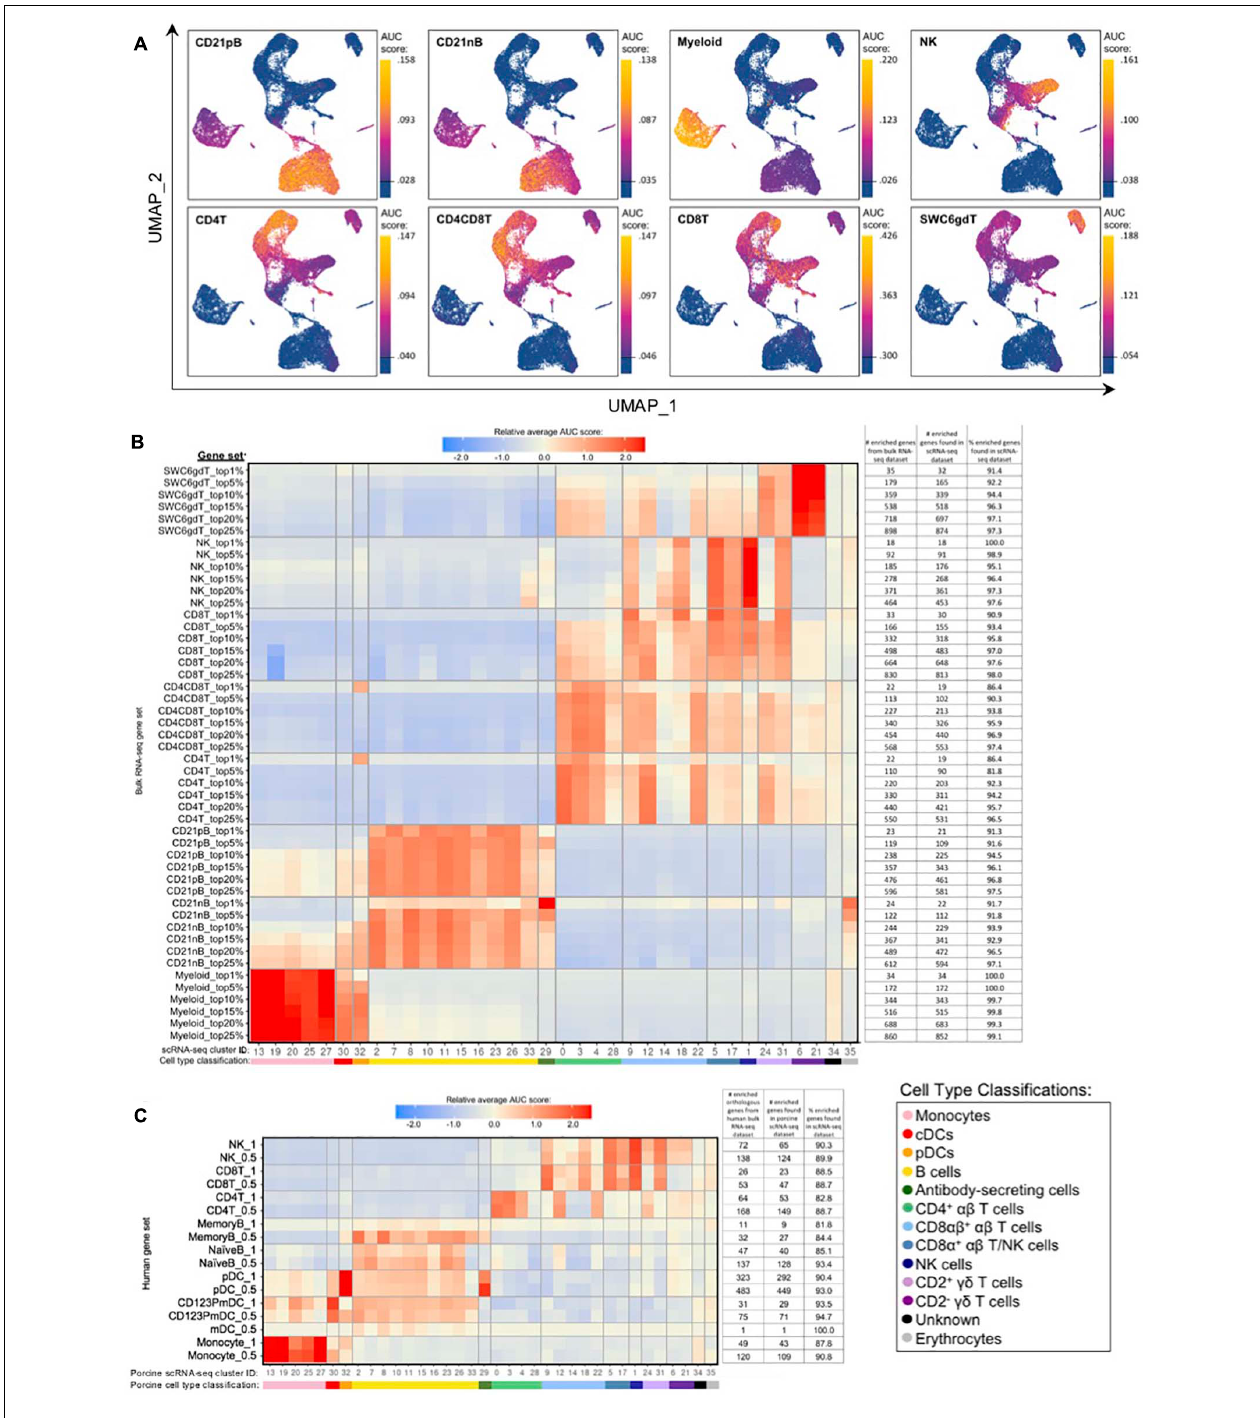
FIGURE 5 | Enrichment of gene signatures from bulkRNA-seq in porcine single-cell clusters. (A) Gene set enrichment scores calculated by AUCell analysis of enriched gene sets from the top 25% of SEGs in pig bulkRNA-seq sorted populations overlaid onto cells of the porcine scRNA-seq dataset visualized in two-dimensional UMAP plot. Each point represents a single cell. The color of the point corresponds to the AUC score calculated for each respective cell. Higher AUC scores correspond to a greater percentage of cells from a gene set being detected in the top 5% of expressed genes in a cell. A threshold for AUC score detection within each gene set was set as shown in Supplementary Figure 10A and is indicated by a horizontal line on the gradient fill scale for each plot. (B) Relative average gene set enrichment scores of scRNA-seq clusters calculated by AUCell analysis of enriched gene sets from porcine bulkRNA-seq sorted data. Scores are relative to other cells within a single gene set comparison (across a row of the heatmap) and are not calculated relative to scores across different gene